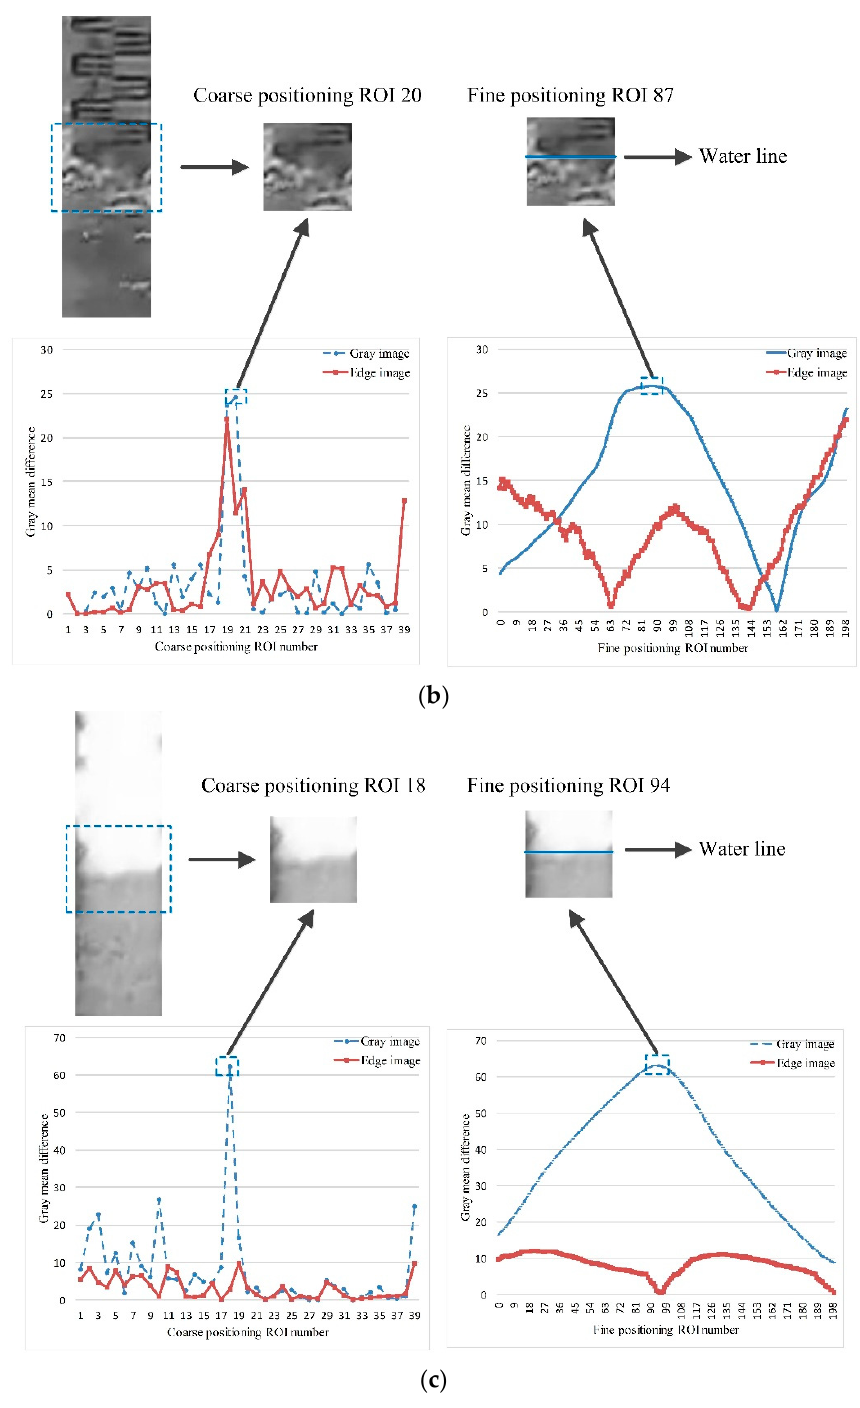
Figure 13. The result of coarse and fine positioning of the water level by the MMD method under three illumination conditions: ( a ) 6:30:00 dim light; ( b ) 9:50:00 water glare; ( c ) 19:20:00 artificial lighting.